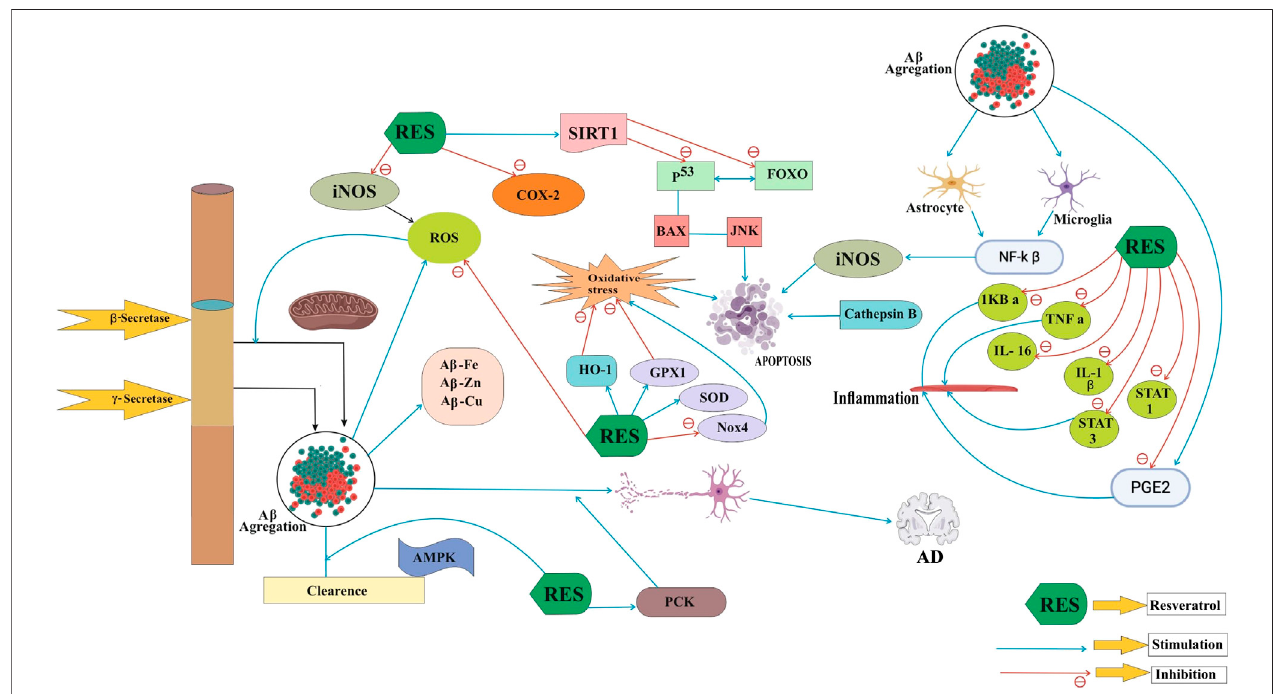
FIGURE 1 | Neuroprotective functions of resveratrol in AD